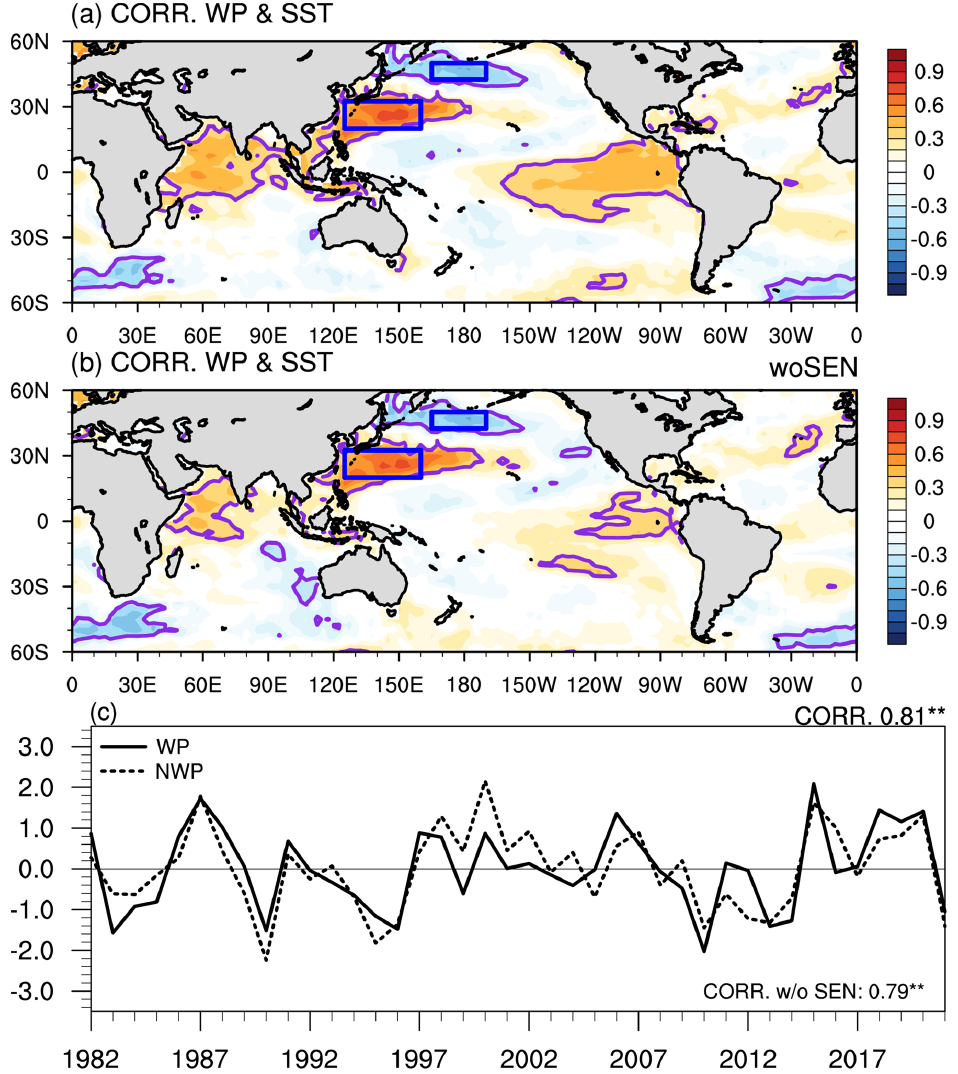
Figure 6. Correlation patterns between SST and the WP index in observations ( a ) for the entire series, ( b ) for the series without the SEN years, and ( c ) for the time series of the WP (solid line) and NWP (dashed line) indices. Significant at the 95% confidence level values are enclosed by a thick line. The TCC for the entire series (series without SEN years) is shown in the top (bottom) right corner of the panels. Blue boxes enclose the areas of SST averaging used for the estimation of the NWP index. Significant at the 99% (95%) level is denoted by a double (single) asterisk. For the numerical representation of this pattern, we suggest a Northwestern Pacific (NWP) SST index defined as the difference between the SST anomalies averaged over the areas within the seesaw pattern (blue boxes in Figure 6): NWP = [SST (20.0–32.5°N, 125.0–160.0°E) − SST (42.5–50.0°N, 165.0–190°E)] (2) Noteworthy, the northern domain of the index is embraced by the North Pacific SST domain of Hurwitz et al. [46] that strongly relates to the WP northern node. The NWP index correlated with the WP index, with TCC being about 0.8 for both the entire series and those without the SEN years (Figure 6c). Correlations of the WP index with the Ni-